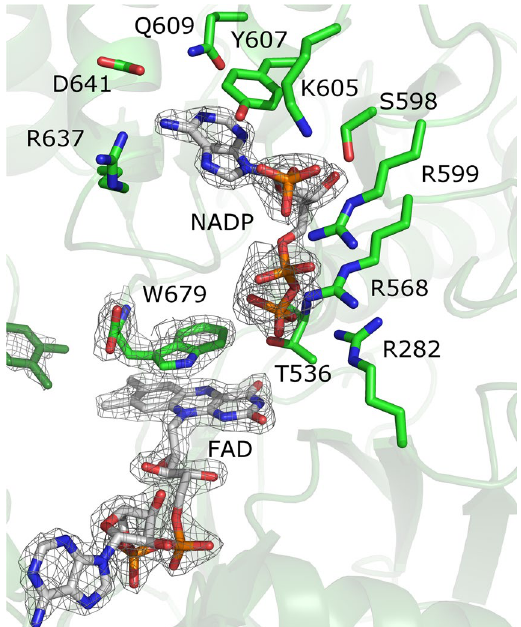
Figure 4. NADPH binding to Ct CPR. Residues interacting with the 3 ′ -phosphate-adenosine-5 ′ -diphosphate part of NADPH are shown. FAD and C -terminal Trp679 are also displayed. FAD and NADPH cofactors and terminal Trp of Ct CPR with 2Fo-Fc electron density maps contoured at 2 σ .